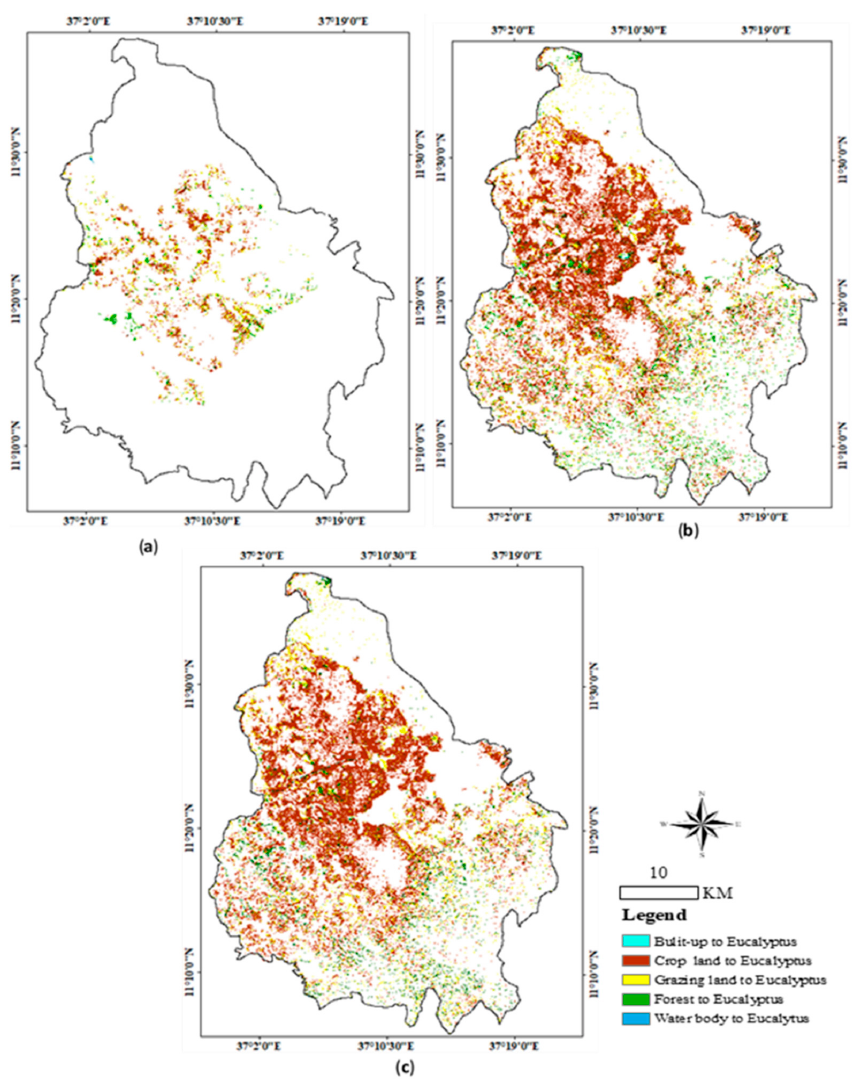
Figure 7. The conversion trends of different land use towards Eucalyptus : ( a ) 1991–2006, ( b ) 2006–2021 and ( c ) 1991–2021.